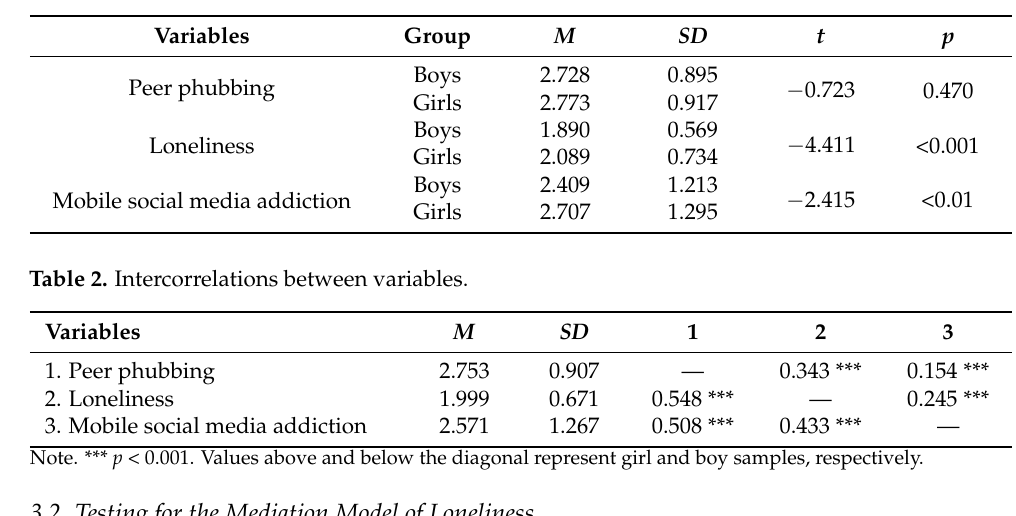
Table 1. Test for the gender differences in the core variables.